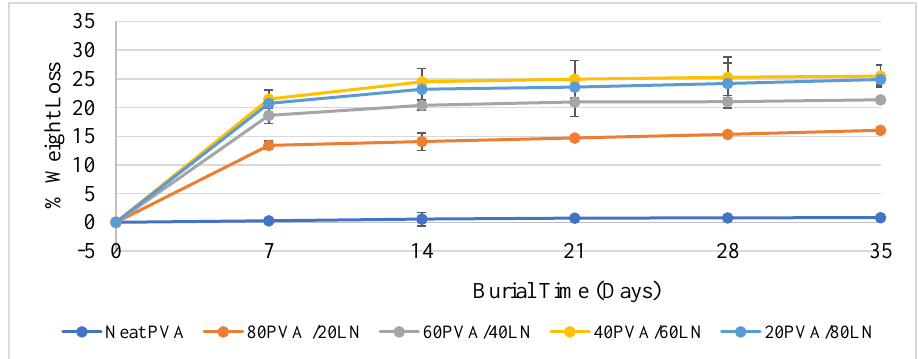
Figure 6. Soil biodegradable weight loss of PVA and PVA/LN nanocomposite films.